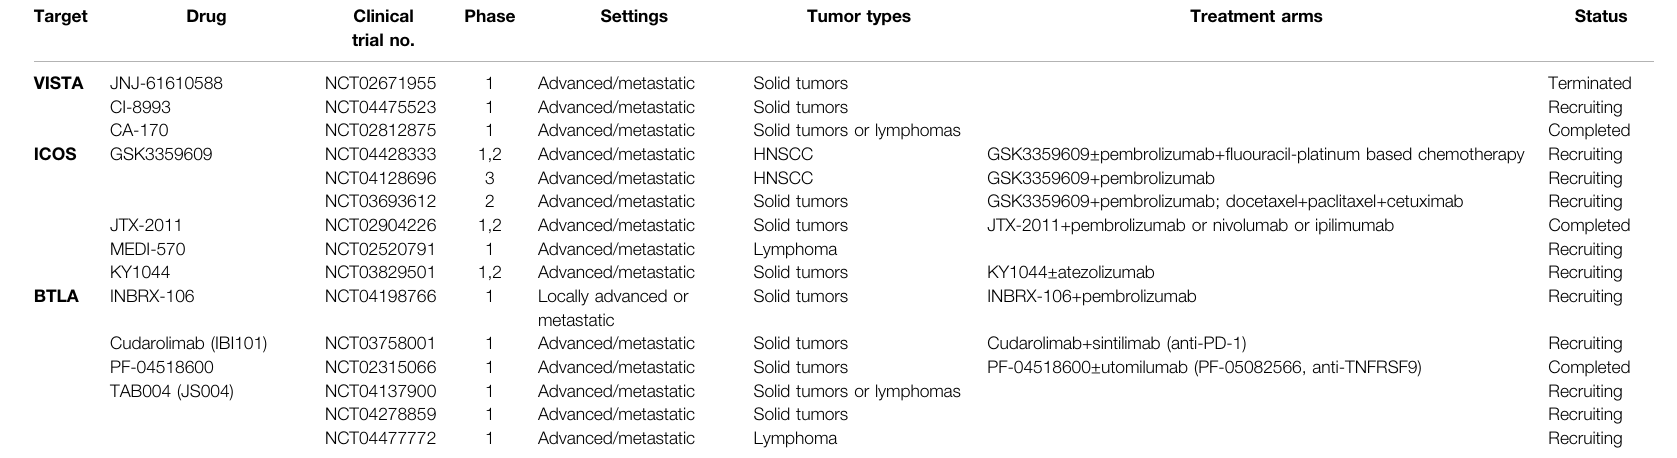
TABLE 3 | ( Continued ) Clinical trials on novel immune checkpoint